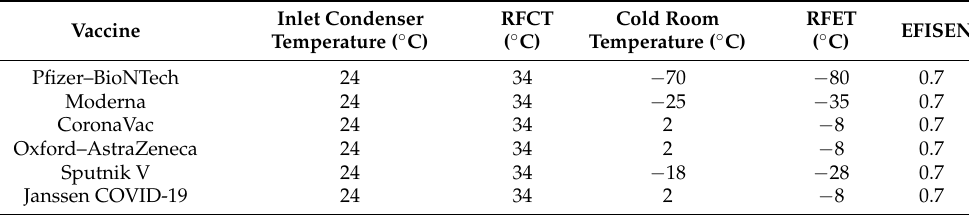
Table 3. Vaccines and equipment characteristics.